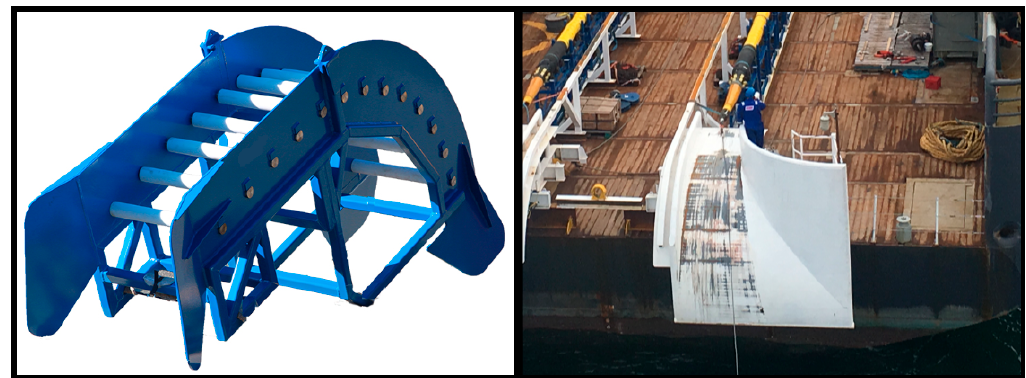
Figure 21. Left side (cable chute with rollers), Right side (cable chute with sliding surface).